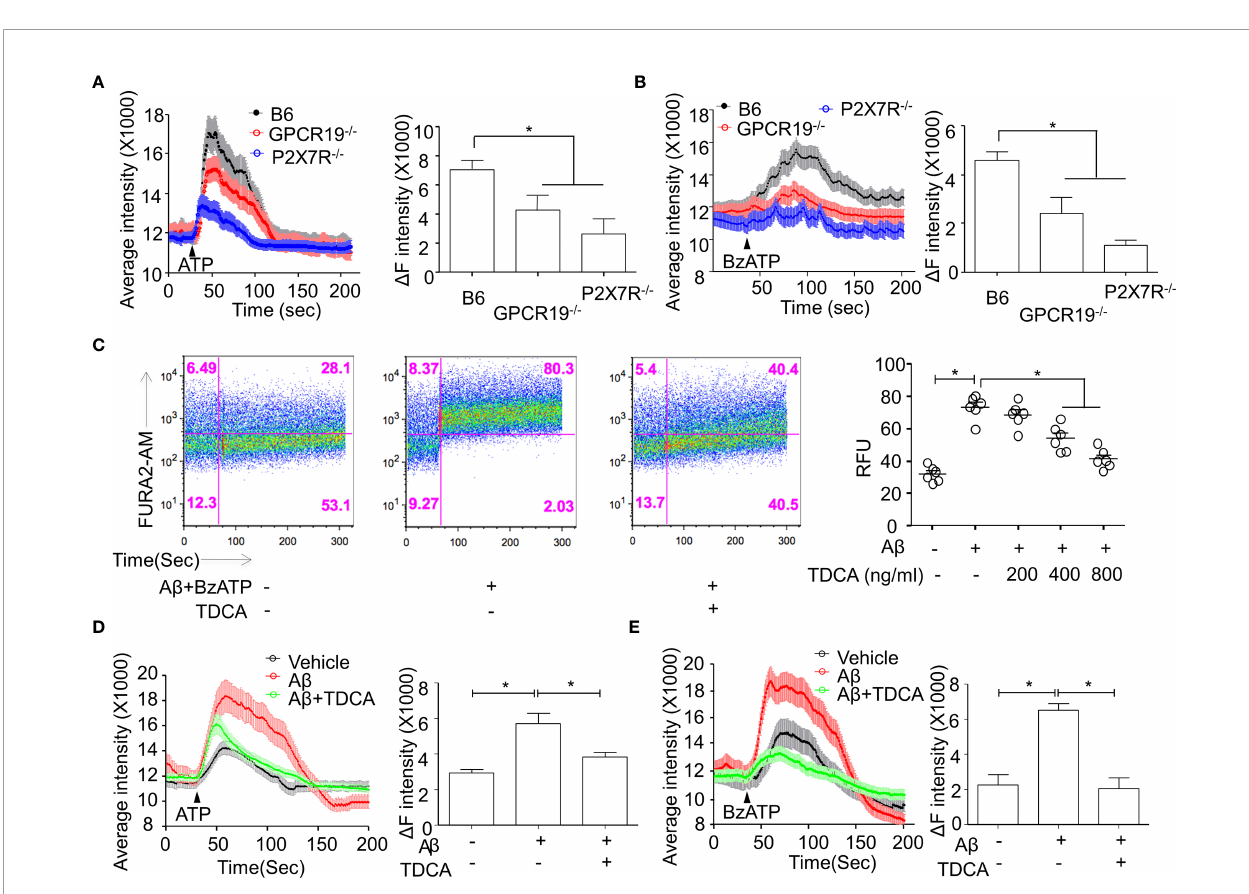
FIGURE 2 | Roles of GPCR19 for P2X7R-mediated Ca ++ mobilization in microglia. (A, B) , Primary microglia from B6, GPCR19 -/- , and P2X7R -/- mice (n = 6/group) were stimulated with ATP (A) (40 µM) or BzATP (B) (40 µM). Average intensity re fl ecting intracellular Ca ++ mobilization (shown in the left panels) and delta intensity (max-min) after stimulation were analyzed (right panel). (C) , Ca ++ mobilization of BV2 cells was measured after treatment with A b , BzATP (300 µM), and TDCA using fl ow cytometry. Representative FACS plots are shown in the left panels, and RFUs from three independent experiments are depicted in the right panel. Ca ++ mobilization of BV2 cells in response to A b and TDCA in the presence of ATP (D) or BzATP (E) is depicted. The individual samples are shown with the mean ± SEM and *P < 0.05 using Student ’ s unpaired t-test.